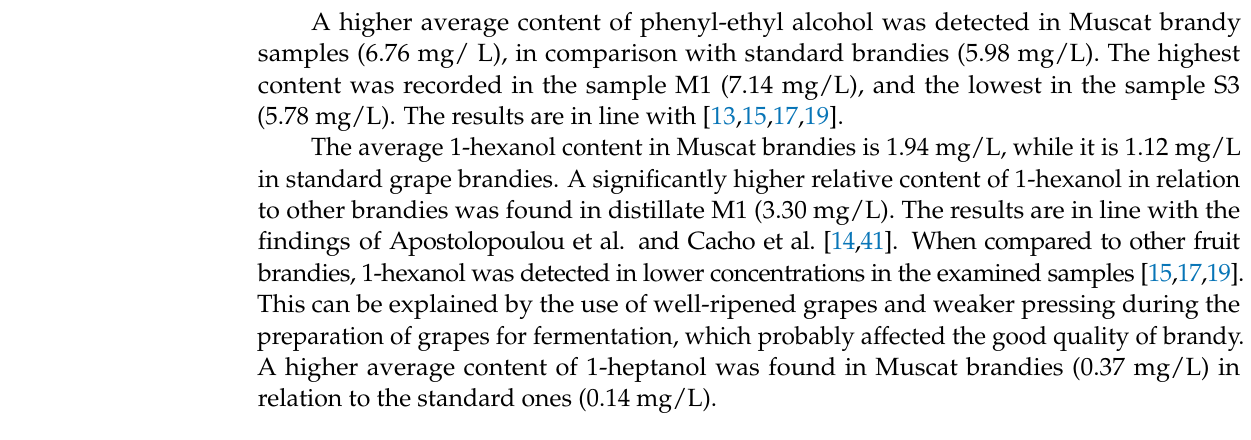
* data are presented as mean ± SD of three independent determinations; S1 (SGB vintage 2011), S2 (SGB vintage 2012), S3 (SGB vintage 2013), M1 (MGB vintage 2011), M2 (MGB vintage 2012), M3 (MGB vintage 2013); ** compounds in PCA analysis; n.d. = not detected; different superscript small letters in the same row indicate significantly different means ( p < 0.05) for type of brandy from different vintages; different superscript